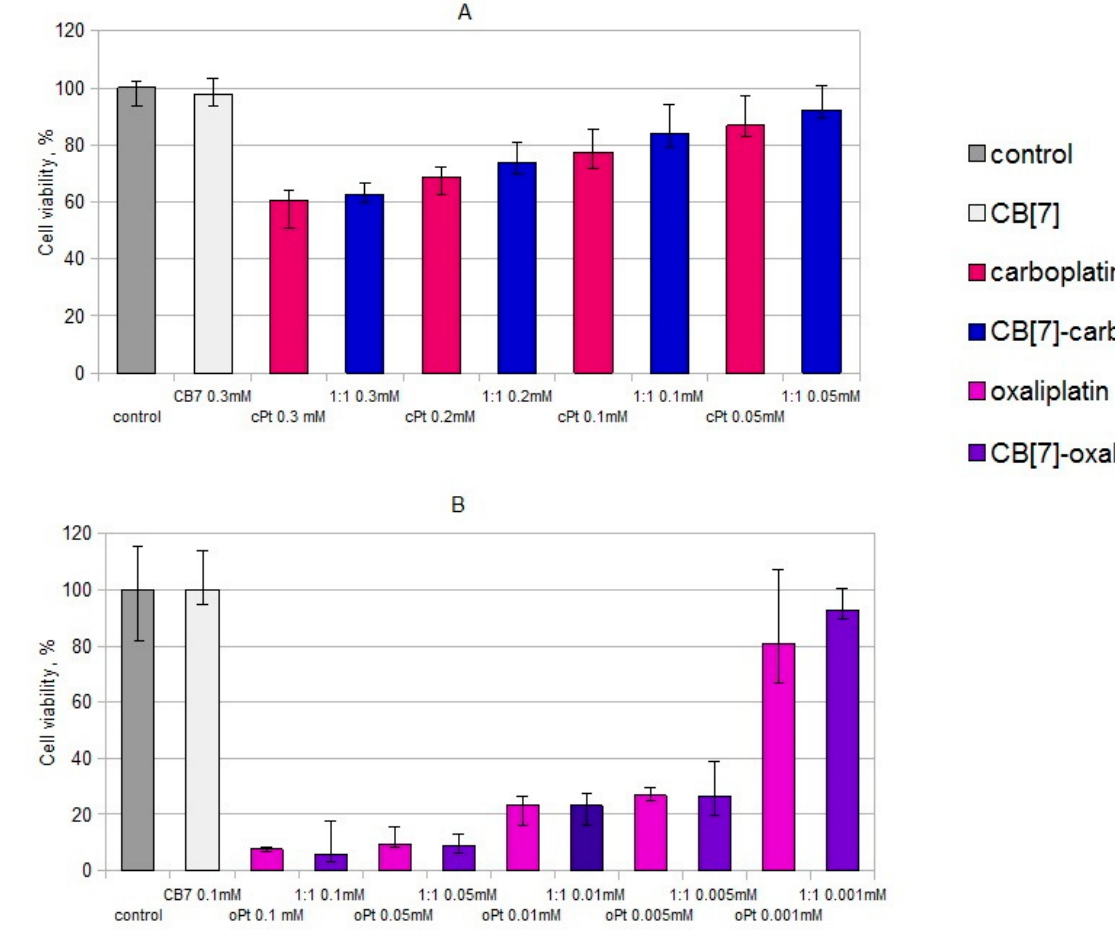
Figure 4. Effects of the CB[7] and platinum drugs on cell viability of PBMCs from healthy donors. ( A ) Effects of the mixture of CB7 and carboplatin (1:1) on cell viability of PBMCs. ( B ) Effects of the oxaliplatin–CB[7] complex on PBMCs’ viability.